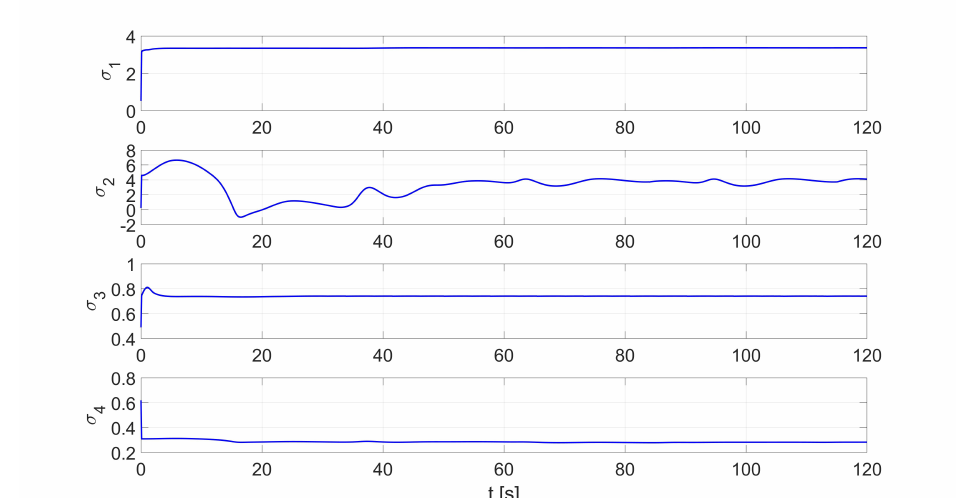
Figure 19. The errors of: ( a ) tracking the reference trajectory ( b ) speed.